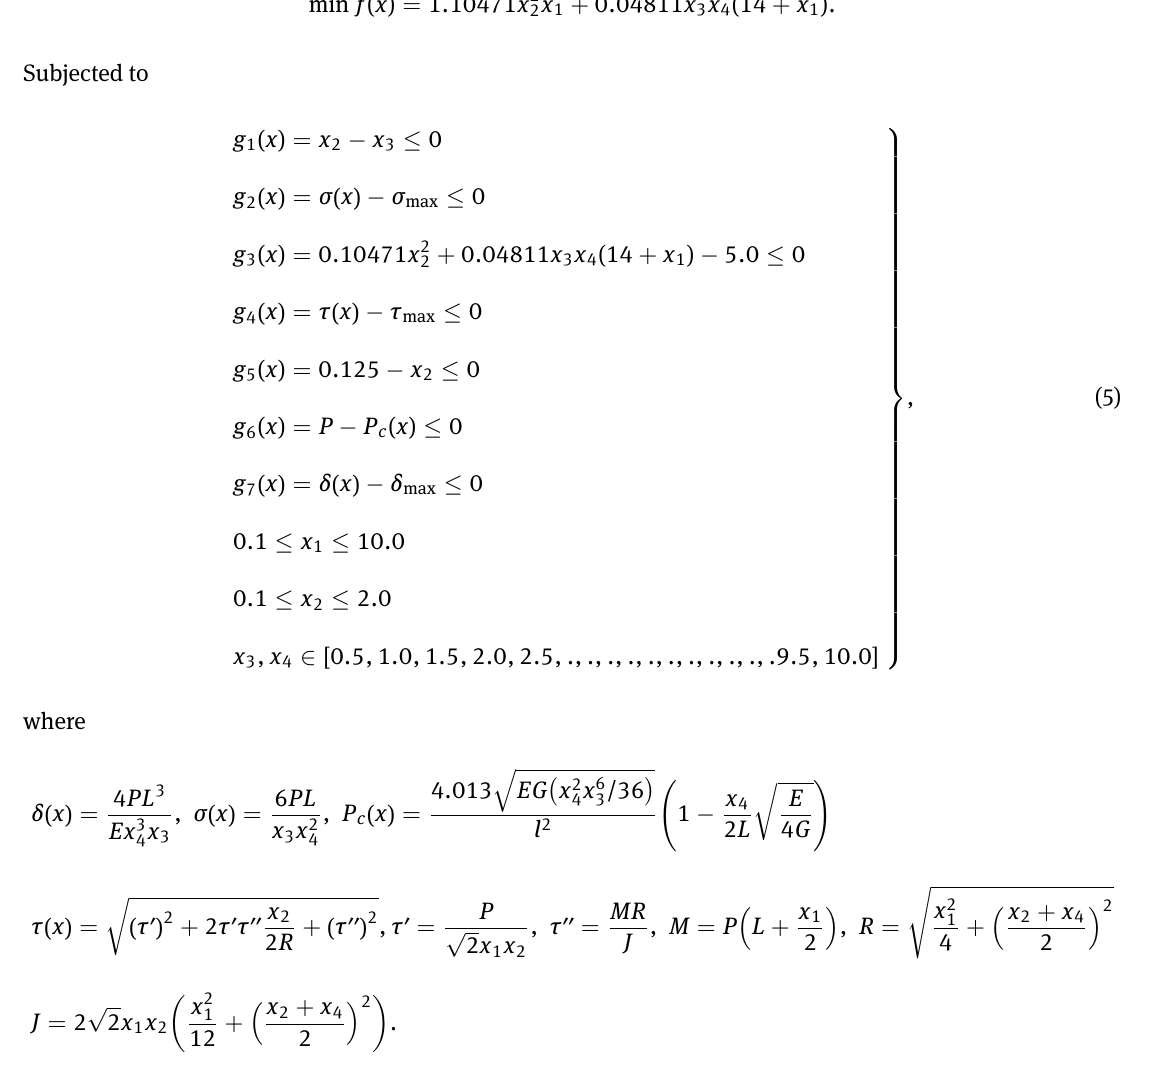
Figure3. Thebest andmeanvalues ofthe objectivefunctionare obtainedin600 functionevaluations as4.3521 and 4.3521, respectively. The optimum solutions of the welded beam design are validated with the optimum solutions of other algorithms, as shown in Table 1. Table 1 presents that the proposed algorithm gives a better optimum design than that of Ref. [34] and equal to that of Refs. [29, 44]. However, the proposed algorithm takes less function evaluation for finding the best objective function value compared to other evolutionary optimization